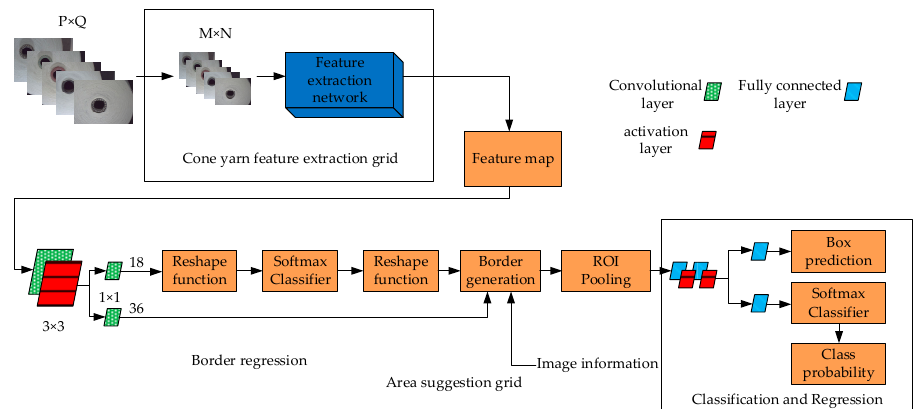
Figure 3. The framework for cone yarn detection based on Faster R-CNN. P × Q represents the